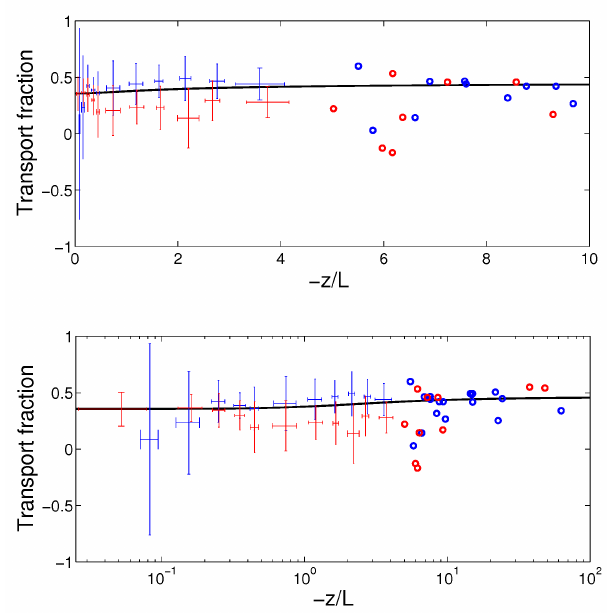
Figure 5. Near-surface transport fraction defined as minus the ra- tio of the total transport term to the sum of buoyancy and shear production. Red circles show hourly averaged data from the after- noon period from 12:00UTC to zero buoyancy flux for − z/L > 5 when data are sparse. Blue circles show the corresponding data from the morning period from positive sensible heat flux up un- til 12:00UTC. The data coverage is successively better for more neutral stabilities and we show averaged data with error bars corre- sponding to ± 1 standard deviation for both afternoon and morning period data for different intervals of the stability parameter − z/L . The intervals used have sizes of 0 . 1 z/L for − z/L < 1 . 0, 0 . 5 z/L for 1 < − z/L < 3 and one additional interval 3 < − z/L < 5 is also included. The lower panel corresponds to the upper, but with a log- arithmic abscissa to better display the very near neutral data and to also include a few hours with − z/L values above 10. In both panels, the model expression for transport fraction, which is applied at the first grid point (1m above the surface), is included as a black line.